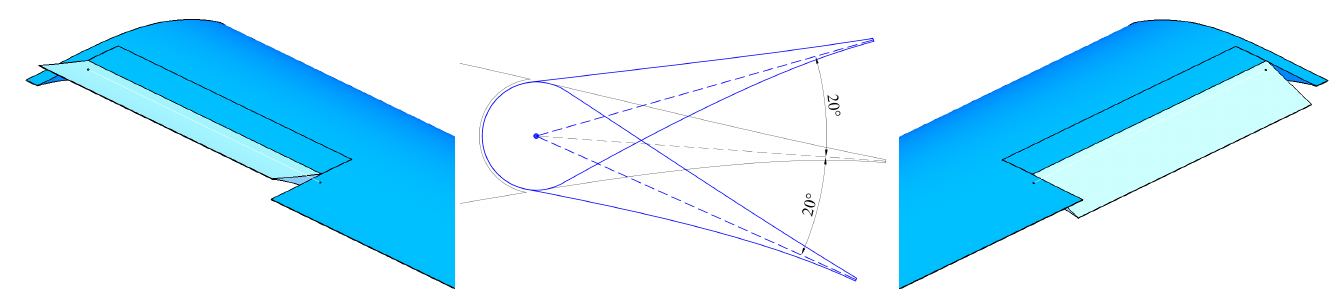
Figure 2. The ( left ) and ( right ) ailerons at their maximum upwards and downwards